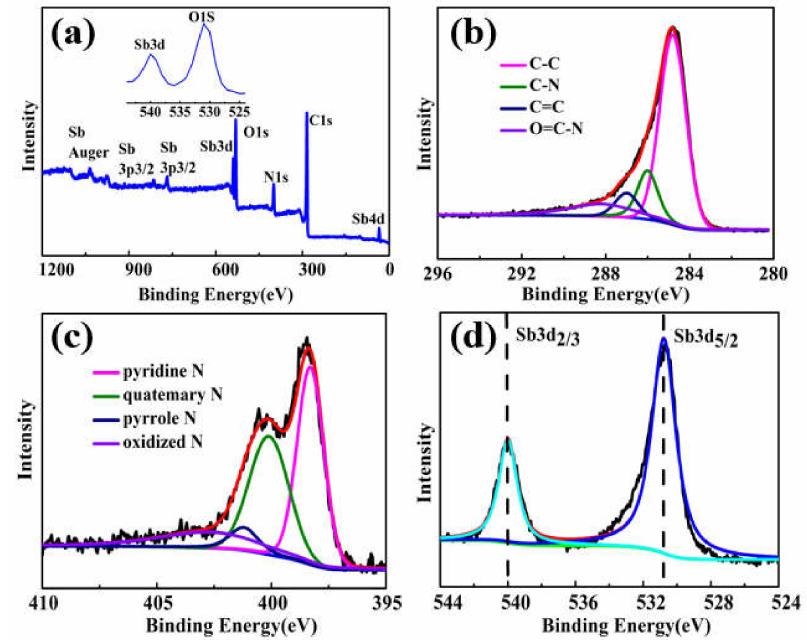
Figure 3. XPS spectra of Sb 3 : ( a ) survey scan, ( b ) C1s, ( c ) N1s, ( d )